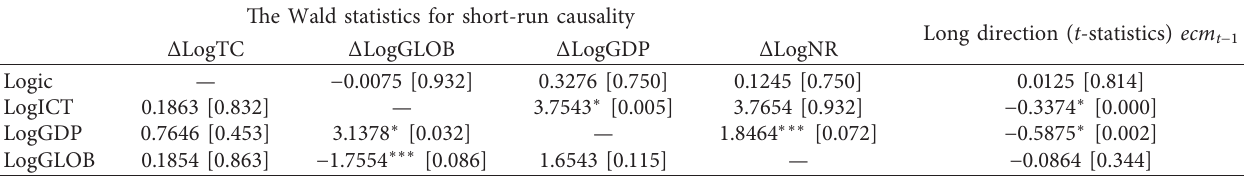
Table 5: Results of